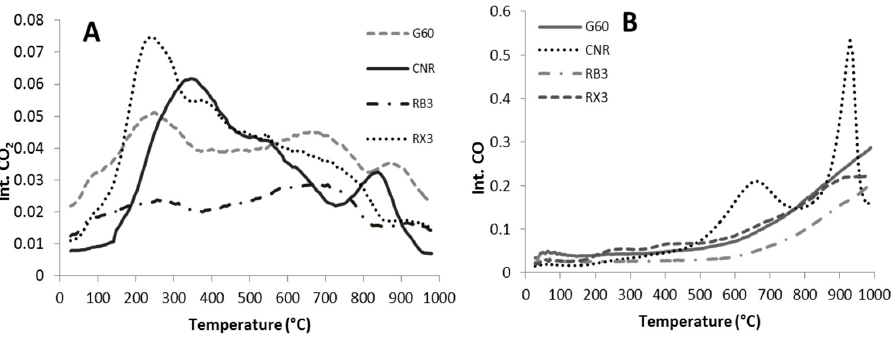
Figure 3. TGA/MS of AC supports. ( A ) Desorption of CO 2 and ( B ) Desorption of CO.